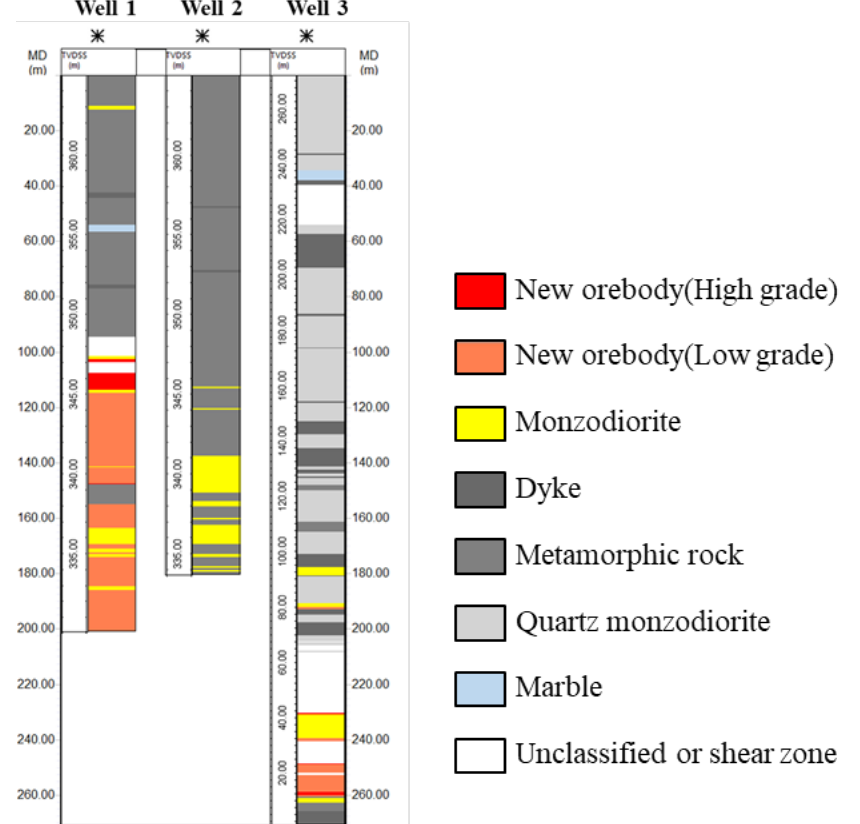
Figure 8. Facies classification profiles of three wells. The results are displayed based on the measured depth without considering the strike and slope.